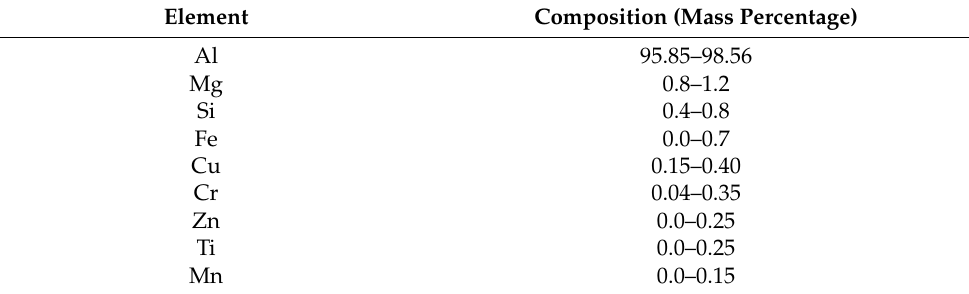
Table 1. Chemical composition of AA 6061 aluminium